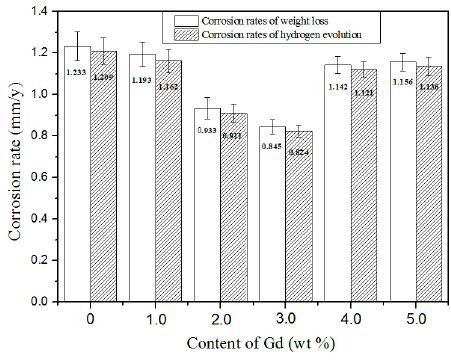
Figure 10. Corrosion rates for Mg–2.0Zn–0.5Zr–xGd alloys measured by weight loss and hydrogen evolution for duration of 120 h.